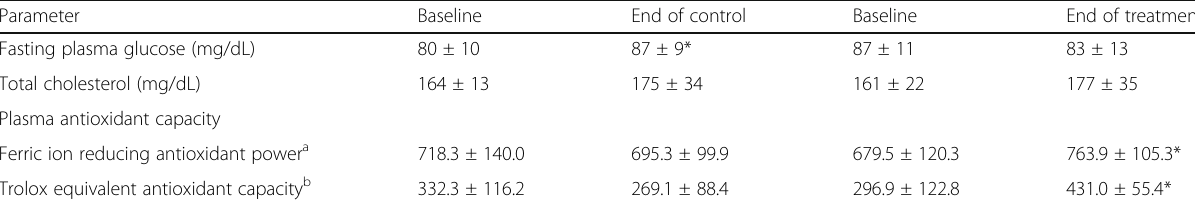
Table 5 Long term efficacy on consumption of finger millet porridge on plasma glucose, serum total cholesterol and plasma antioxidant levels of healthy